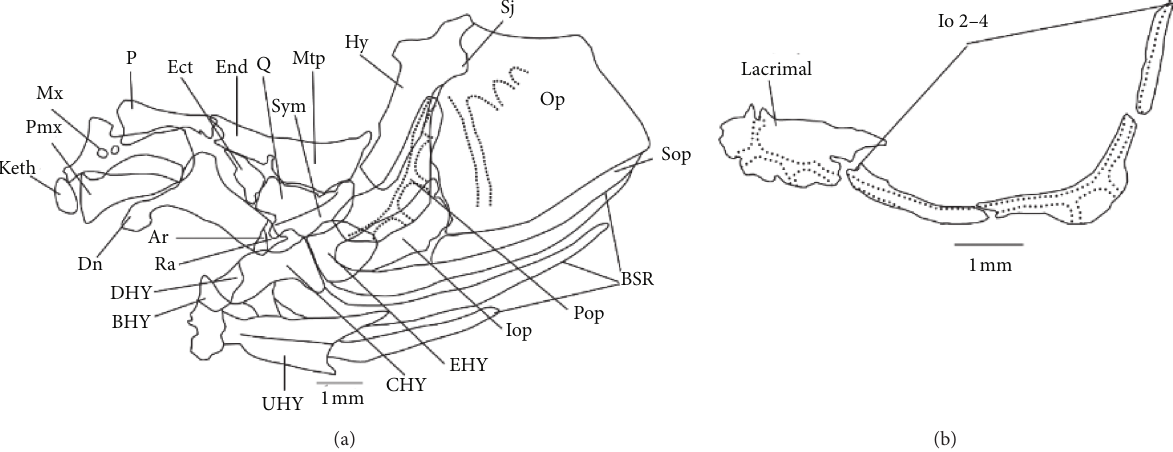
Figure 2: (a) The suspensorium, opercular series, and hyoid arch and (b) circumorbital series in G. rossica . Ar: articular; BBR: basibranchial; BHY: basihyal; BSR: branchiostegal; CBR: ceratobranchial; CHY: ceratohyale; DHY: dorsal hypohyal; EBR: epibranchial; Ect: ectopterygoid; End: endopterygoid; EHY: epihyal; HBR: hypobranchial; Hy: hyomandibulare; Io 2-4: infraorbital 2-4; Iop: interopercle; Keth: kinethmoid;